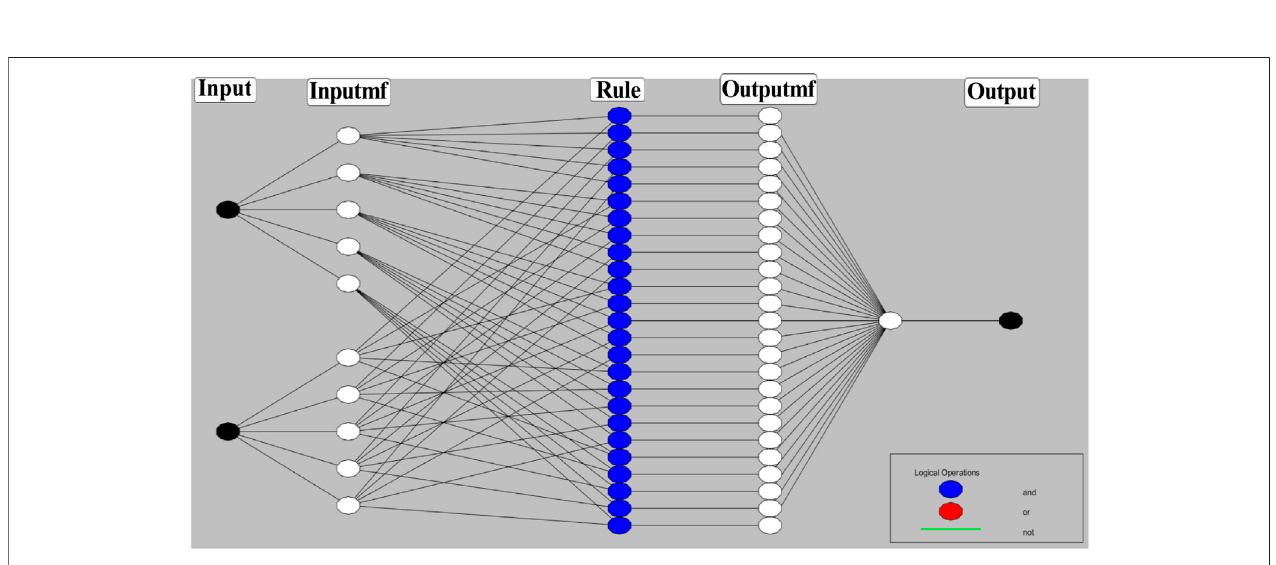
FIGURE 13 | Generated ANFIS structure based on 25